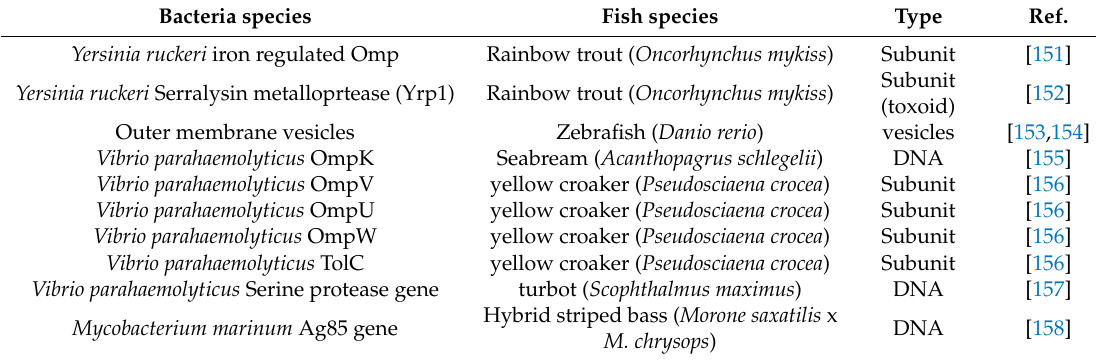
Table 5. Immunogenic proteins used for recombinant vaccine production for other bacteria